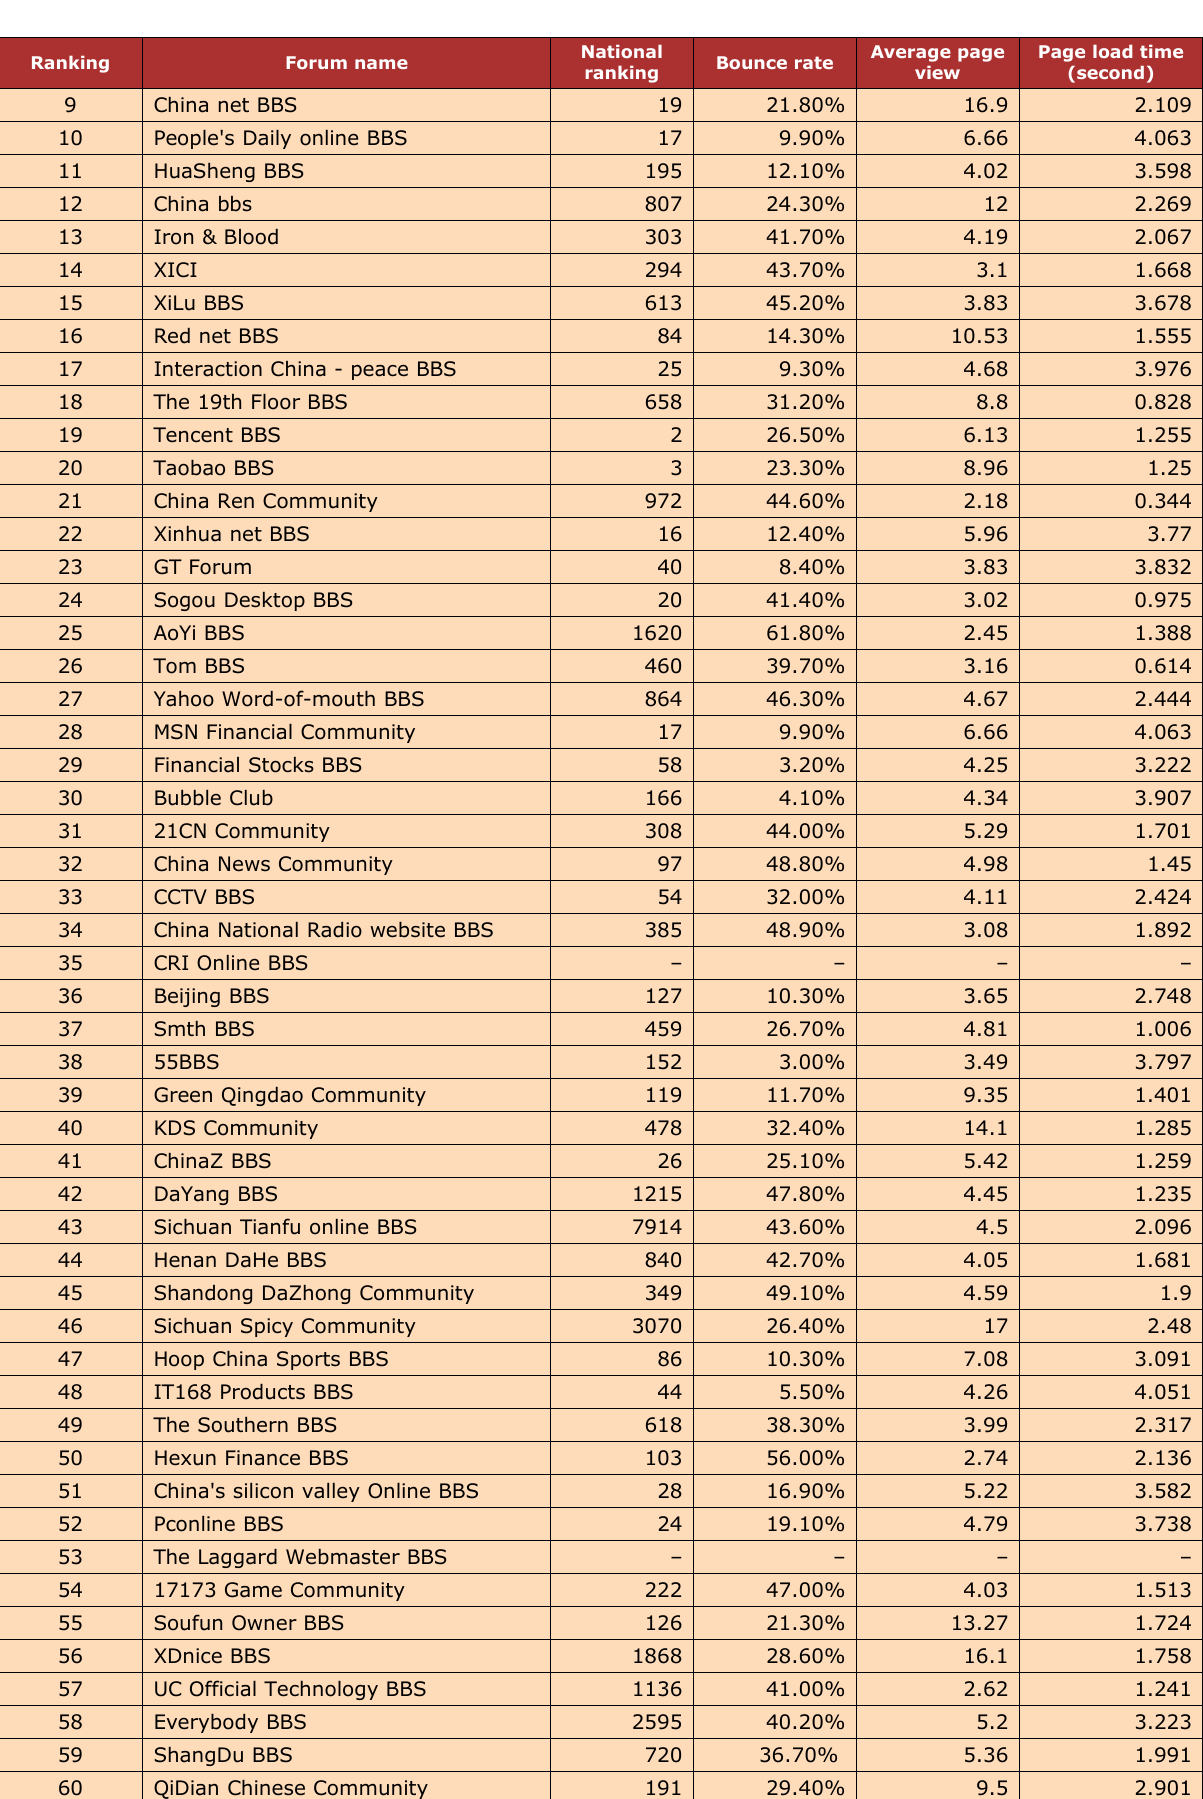
Table 1. Alexa Statistical data of sample